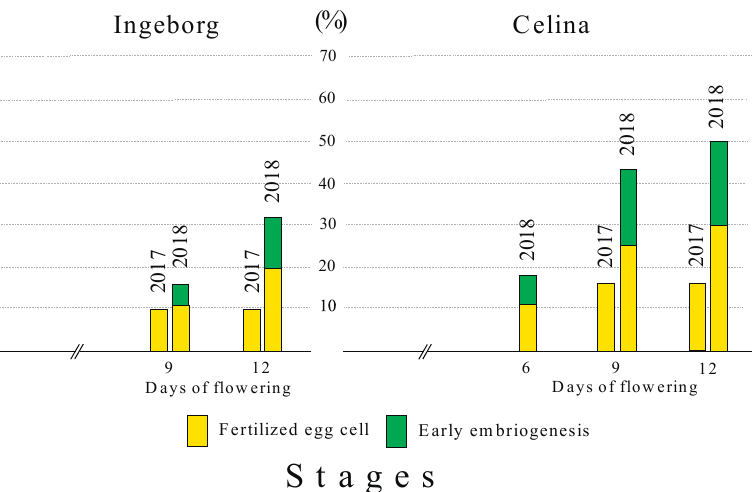
Figure 6. Percentage of embryo sacs with fertilized egg cell or with early embryogenesis in open-pollination of pear cultivars ‘Ingeborg’ and ‘Celina’ during 2017 and 2018. The standard deviation (SD) of studied traits presented in percentages was 2–3%.